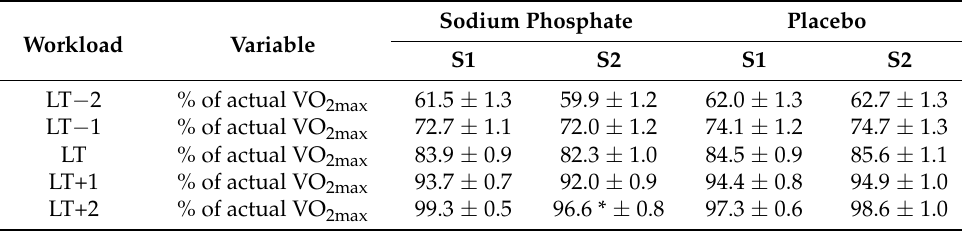
Table 1. Exercise intensity presented as a percentage of actual maximal oxygen